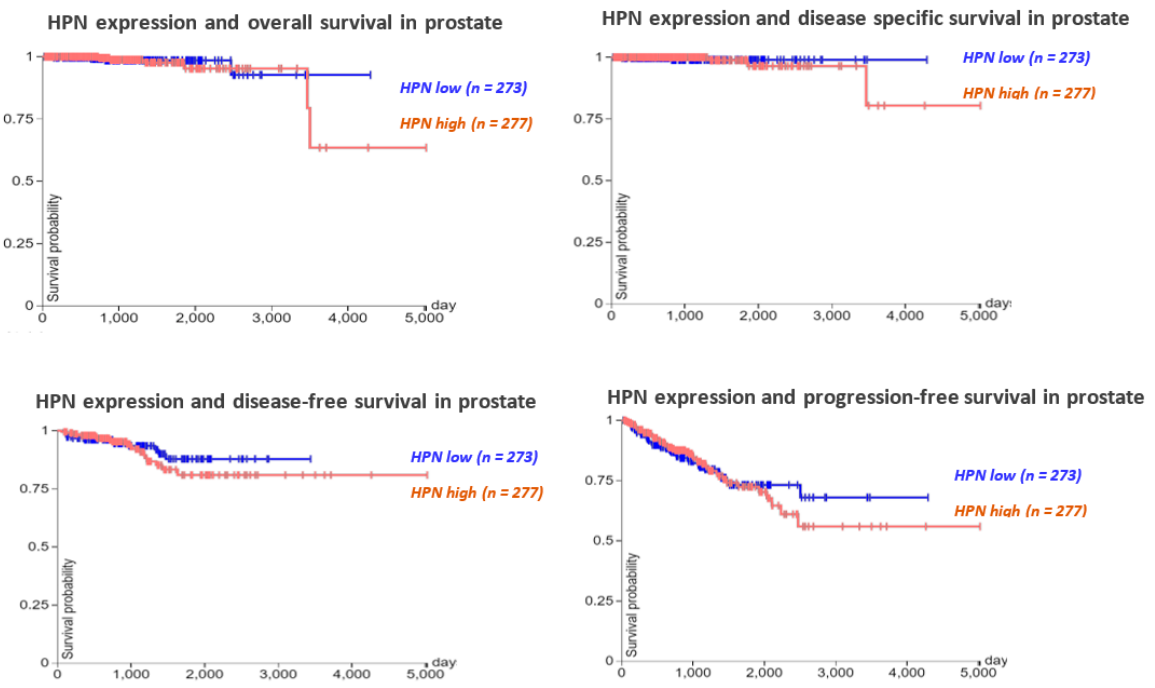
Figure 4. The association between HPN expression levels and overall survival, disease-specific survival, disease-free survival, and progression-free survival in prostate cancer (TCGA data, 550 cases of prostate cancer).